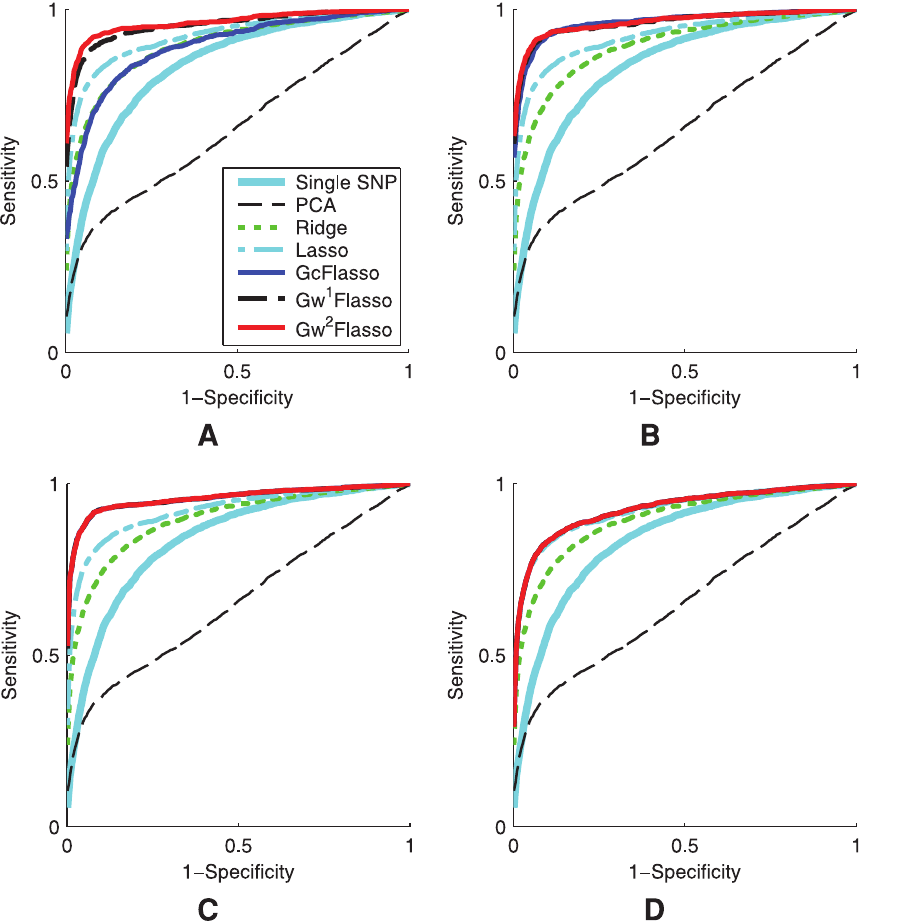
Figure 7. ROC curves comparing association analysis methods when the threshold r for producing the QTN varies. Panels show the threshold (A) r ~ 0 : 1 , (B) r ~ 0 : 3 , (C) r ~ 0 : 5 , and (D) r ~ 0 : 7 . The sample size was 100, and the association strength was 0.8. The results were averaged over 50 simulated datasets. In Panels (B) and (C), the ROC curves for G c Flasso , G 1 Flasso and G 2 Flasso almost entirely overlap. In Panel (D), the ROC w w curves for lasso, G c Flasso , G 1 Flasso and G 2 Flasso almost entirely overlap. w w doi:10.1371/journal.pgen.1000587.g007 Flasso , the benefit of borrowing information across and G 2 w Flasso and G 2 Flasso remained Figure 9C. However, G 1 correlated traits outweighes the adverse effect of encouraging the w w dominating over the other methods. Our results suggest that regression coefficients to be fused even when their values are not Flasso with the flexibility of the weighted fusion penalty as in G 1 the same. w